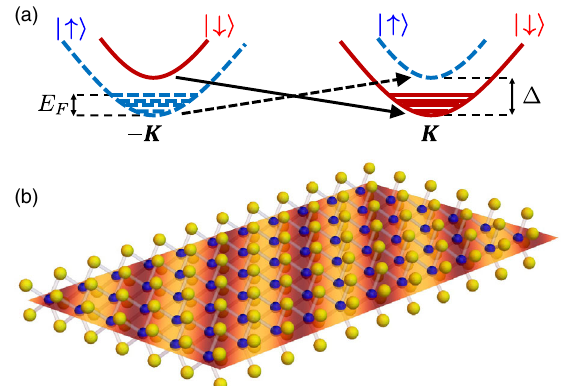
FIG. 4. The intervalley Coulomb interaction in ML-TMDs. (a) Spin-conserving charge excitations from the − K to the K valleys. Electrons need to overcome the spin-splitting energy gap in the conduction band. (b) The resulting shortwave charge fluctuations in the